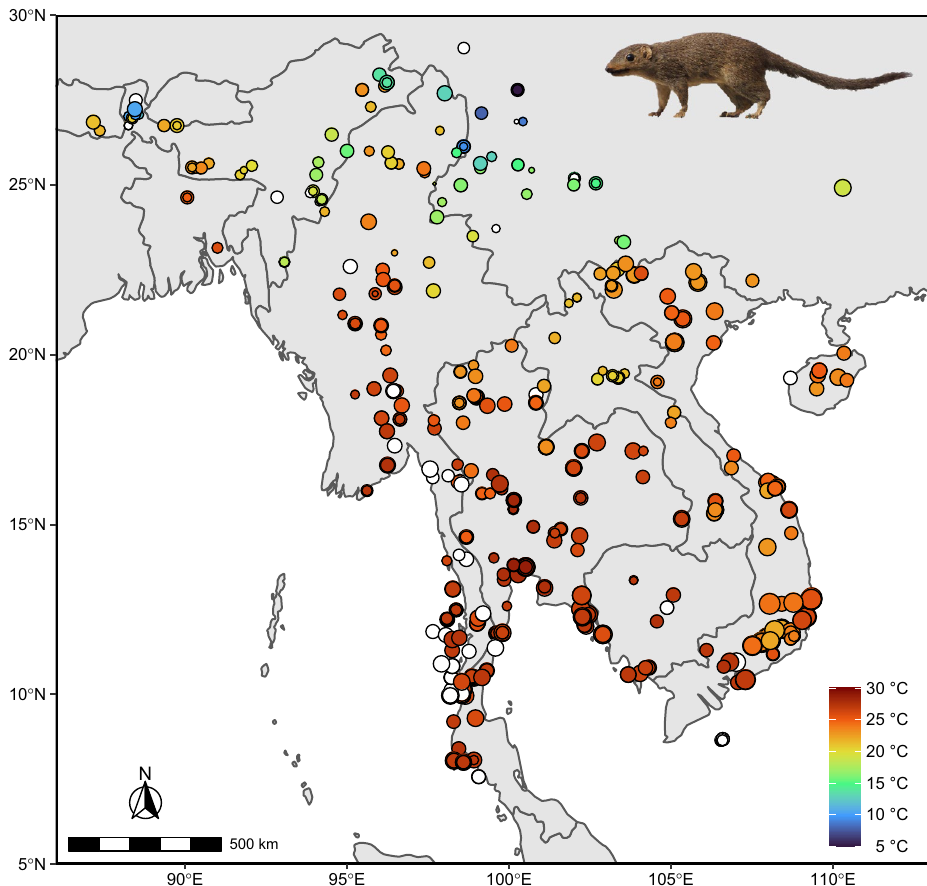
Figure 1. Locality map of specimens included in our study. Point size corresponds to relative size of individual based on Principal Component 1 (Supplementary Table S1). Point color reflects the average annual temperature at each locality in the year when the specimen was collected. White circles indicate localities for which we do not have historical climate data for the collection year. Map was generated using the packages ggplot2 28 , rnaturalearth 29 , and ggspatial 30 in R (version 3.5.1) 31 . Image in the upper right corner depicts a Northern Treeshrew (photo by Daderot, CC0 1.0, Wikimedia